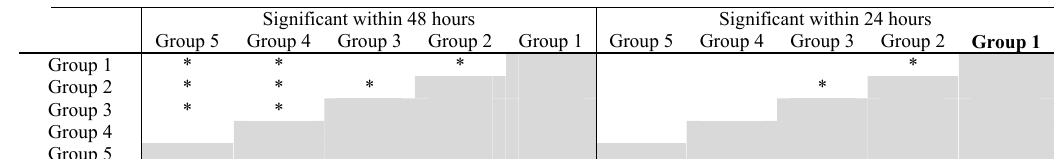
Table 5. Significance at concentration 1 at P<0.001 Table 5: Significance at concentration 1 at